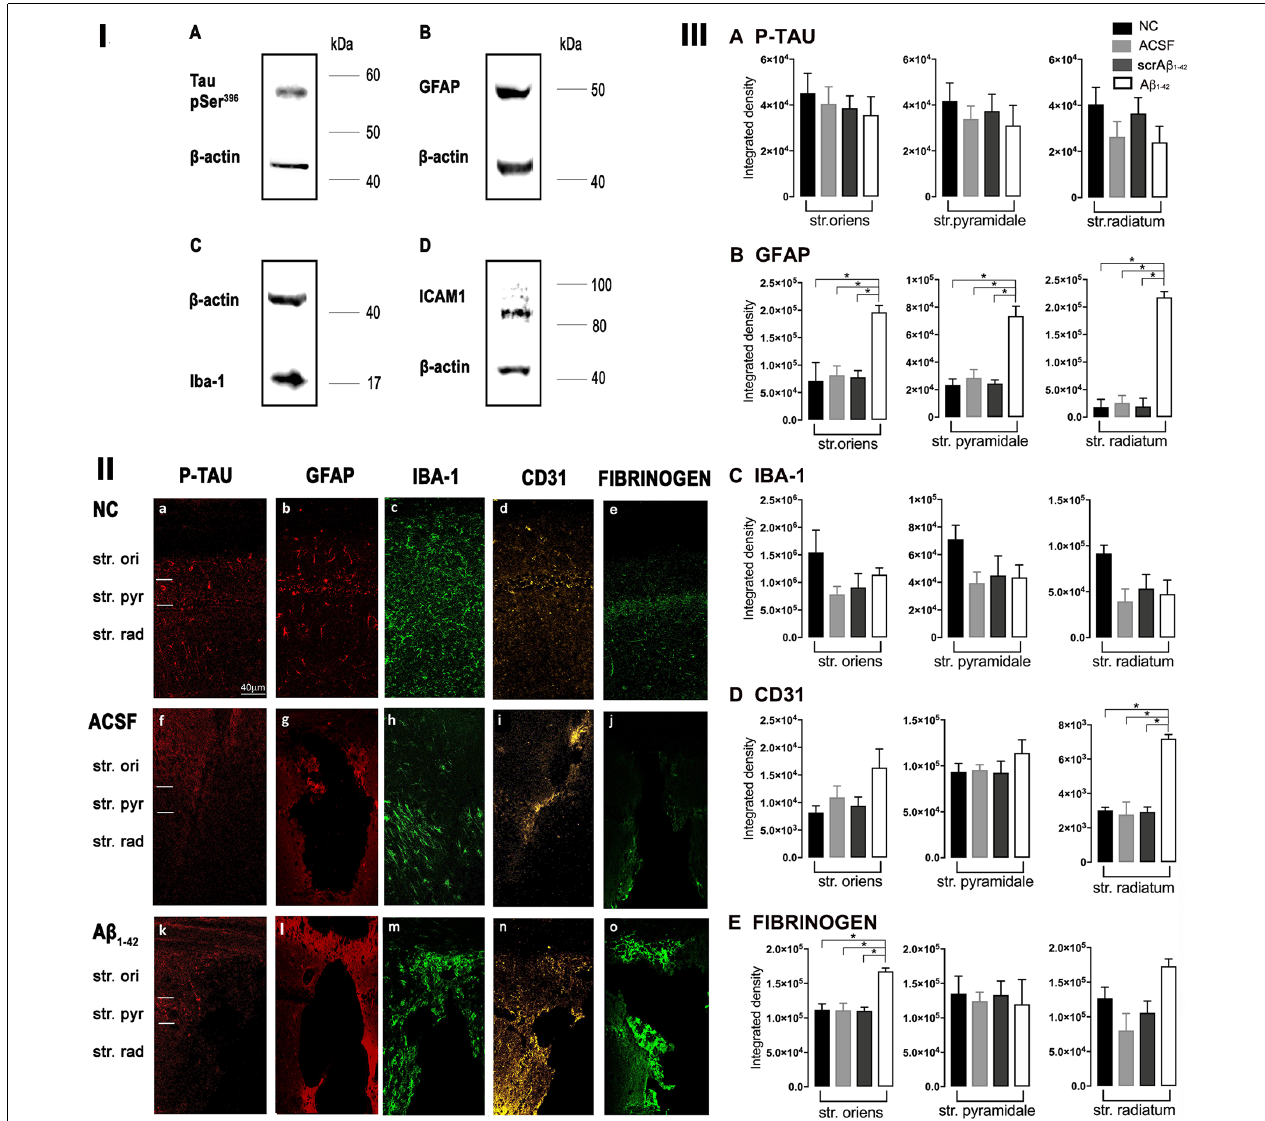
FIGURE 1 | Panel I: Western blot against mouse brain protein homogenates probed with p-tau (A) , glial fibrillary acidic protein (GFAP; B ), Iba-1 (C) , and ICAM-1 (D) . Observed band sizes: p-tau ∼ 58 kDA, GFAP ∼ 50 kDA, Iba-1 ∼ 17 kDA and ICAM-1 ∼ 85 kDA. Panel II: Representative images showing immunolabeling of p-tau, GFAP, Iba-1, CD31, and fibrinogen at the injection site, 3 days post-injection in NC (a–e) , ACSF- (f–j) , and A β 1–42 -injected (k–o) mice. Scale bar (40 µ m). Panel III: Graphs showing quantification at the injection site in the CA1 hippocampal region of p-tau, GFAP, Iba-1, CD31, and fibrinogen immunolabeling density, 3 days post-injection in NC, ACSF-, scrA β 1–42 - and A β 1–42 -injected mice. Data expressed as mean ± SEM (Kruskal–Wallis test; * p < 0.05, n =